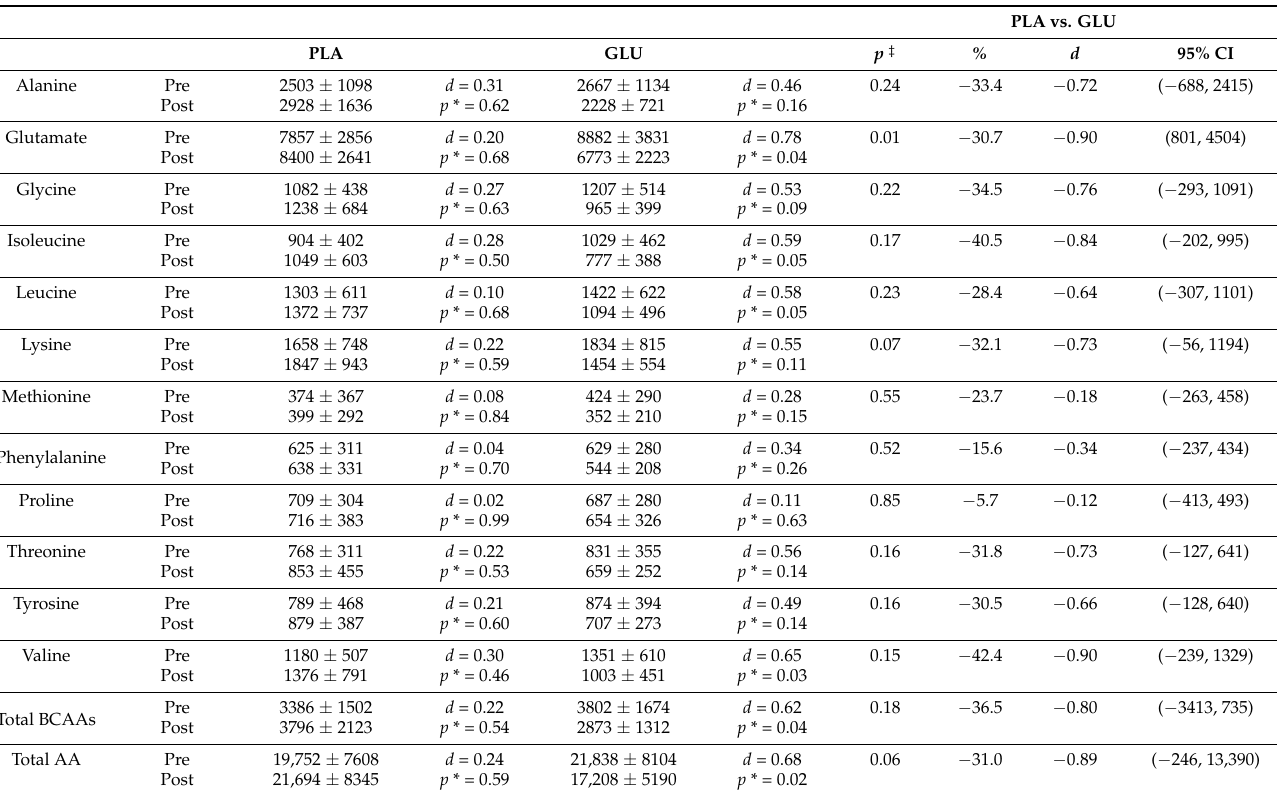
Values inside table are means ± standard deviations for each specified variable and time point. Bold-type face = Between-group difference ( p < 0.05). * = p -value computed using paired samples t -test. ‡ p -value computed using 2 × 2 within-within factorial